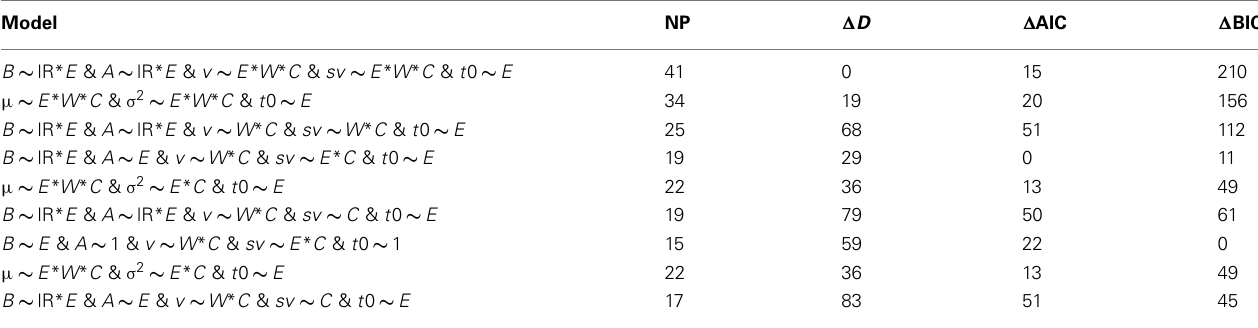
Table 1 | Model selection statistics for the LBA and LNR top models and the conventional LBA top model (upper section) and the bestAIC (middle section) and BIC (bottom section) model in each